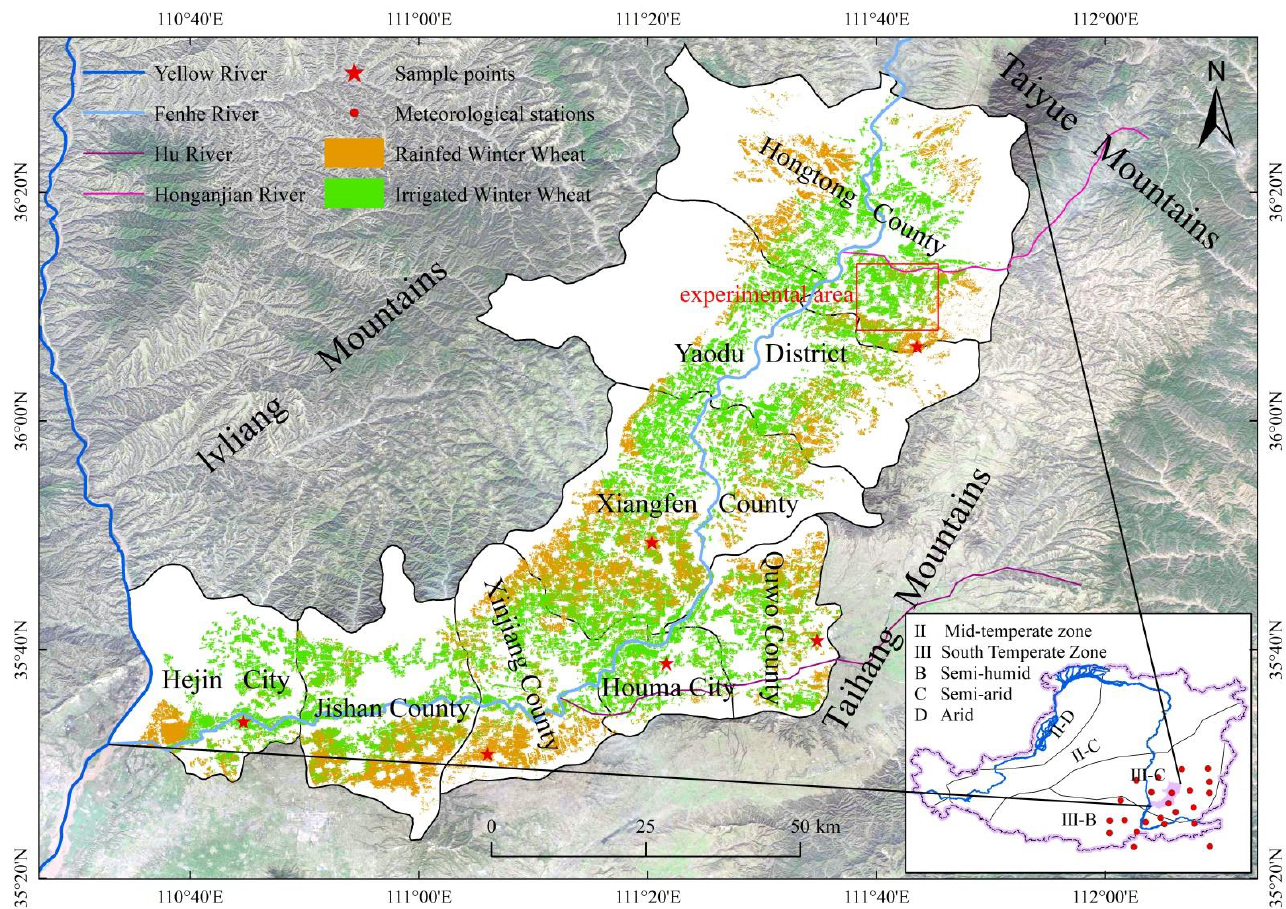
Figure 1. The geographical location of winter wheat, sample point distribution, and meteorological stations in the study area.